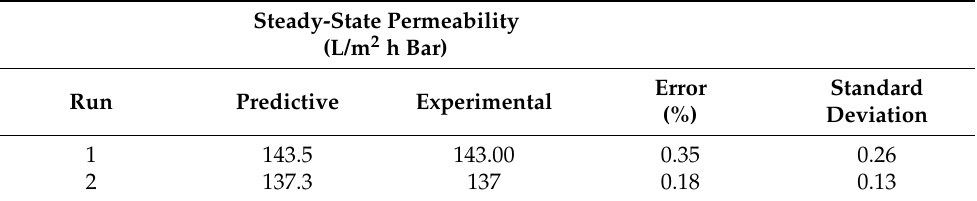
Table 8. Steady-state membrane permeability values for the model and